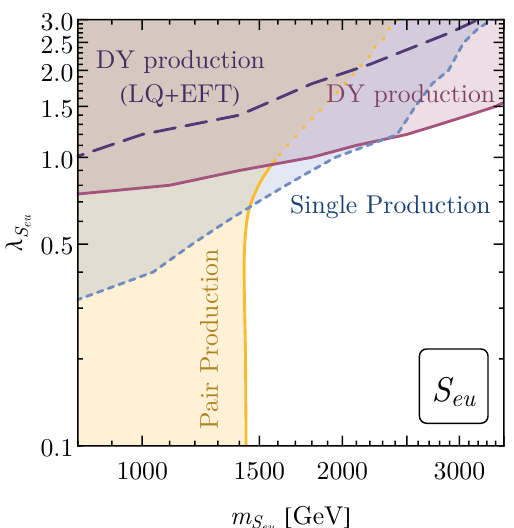
c E c from Run 2 Figure 2. Bounds on scalar minimal leptoquark, S eu , with (cid:13)avor structure U pair production (yellow) [12], projected Run 2 single production (blue), and Run 2 DY-production (purple) [13] at the LHC. For the single production search, no Run 2 analysis has been published yet, and thus our \bound" is only a projected limit. Note that the pair-production search excludes leptoquarks with low masses while the DY search is very constraining at large coupling (cid:21) . This leaves only a relatively small region of parameter space with intermediate masses and couplings which can be probed by single production. Note however that since the DY search does not involve the reconstruction of a resonance it can be weakened in the presence of a four-fermion operator which destructively interferes with leptoquark exchange. We indicate the weakened DY bound in the presence of a maximally interfering operator with a dashed purple line. This leptoquark also contributes to atomic parity violation and parity-violating electron scattering experiments; we derive the corresponding bounds in appendix B and include them in (cid:12)gure